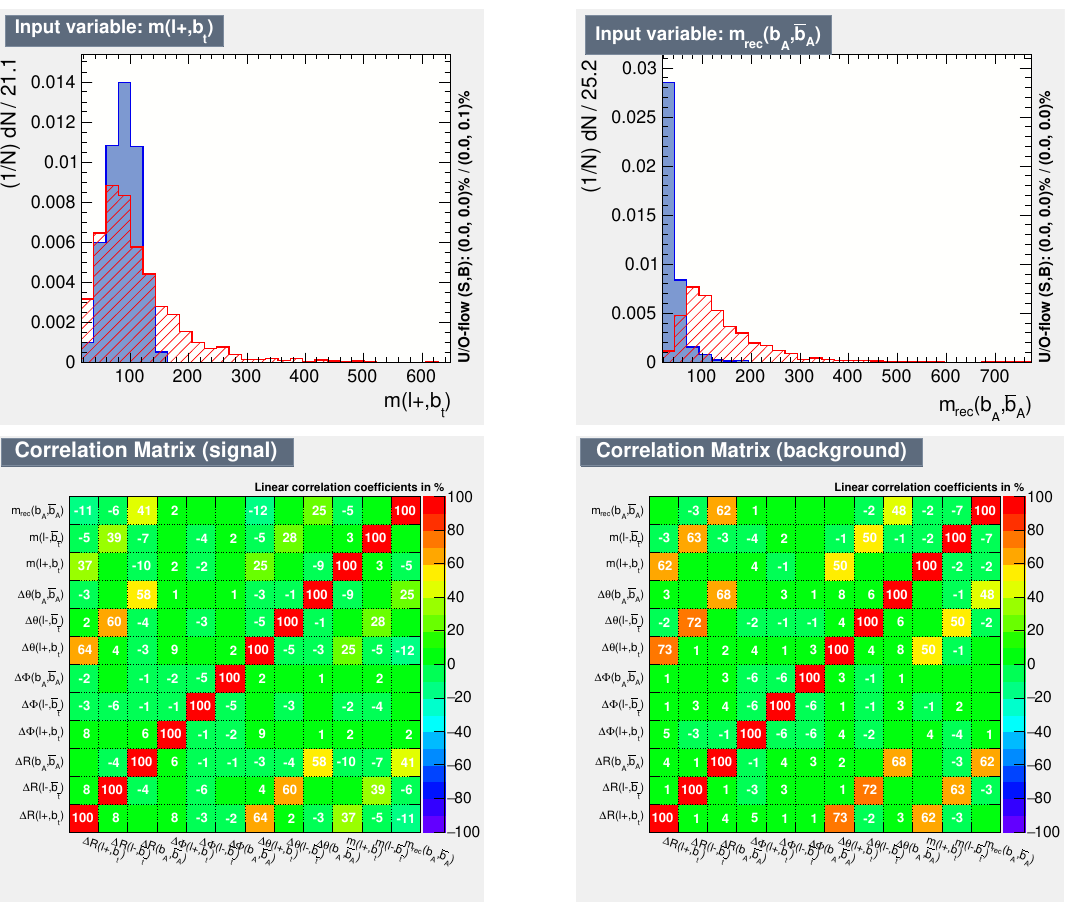
Figure 8. Invariant masses for the systems ( l + ; b t ) at parton level (top left) and ( b A ; (cid:22) b A ) obtained with truth-matching (top right), for t (cid:22) tA events with m A = 40 GeV. Below, we have the matrix correlations between the TMVA input variables for the signal (left) and background (right).